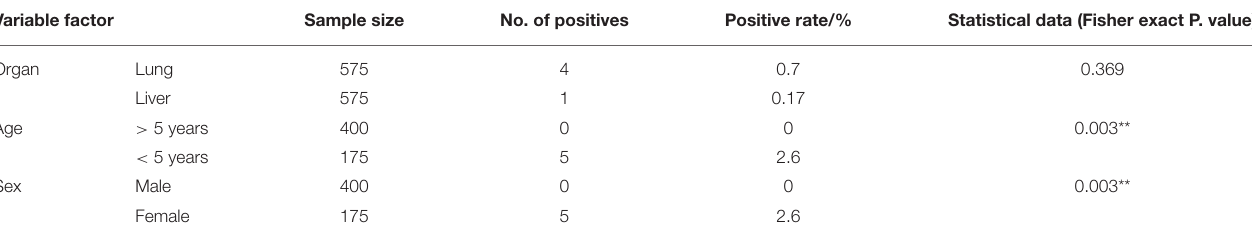
TABLE 3 | Summarizes the data of the possible associations between the occurrence of hydatid cysts in cattle and the potential explanatory individual variable factors of these detected cysts. Variable